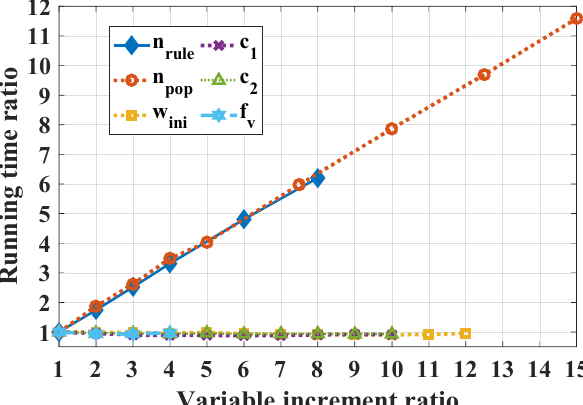
Figure 3. Influence of variable increment ratio on running time, noting that both n rule and n pop exhibit a slope coefficient of 0.75.